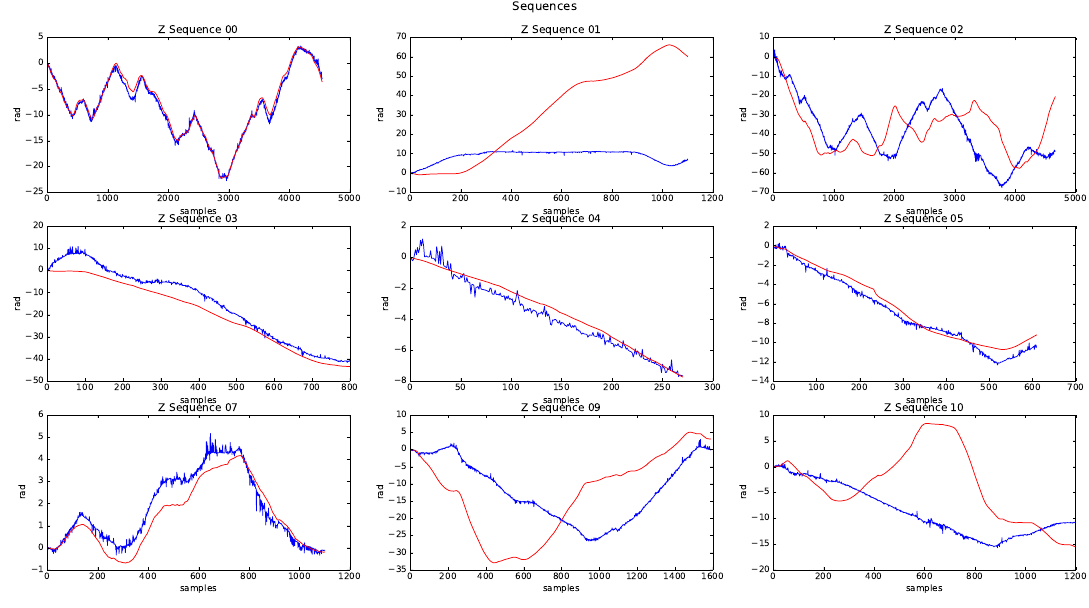
Figure 24. Height sequences results.